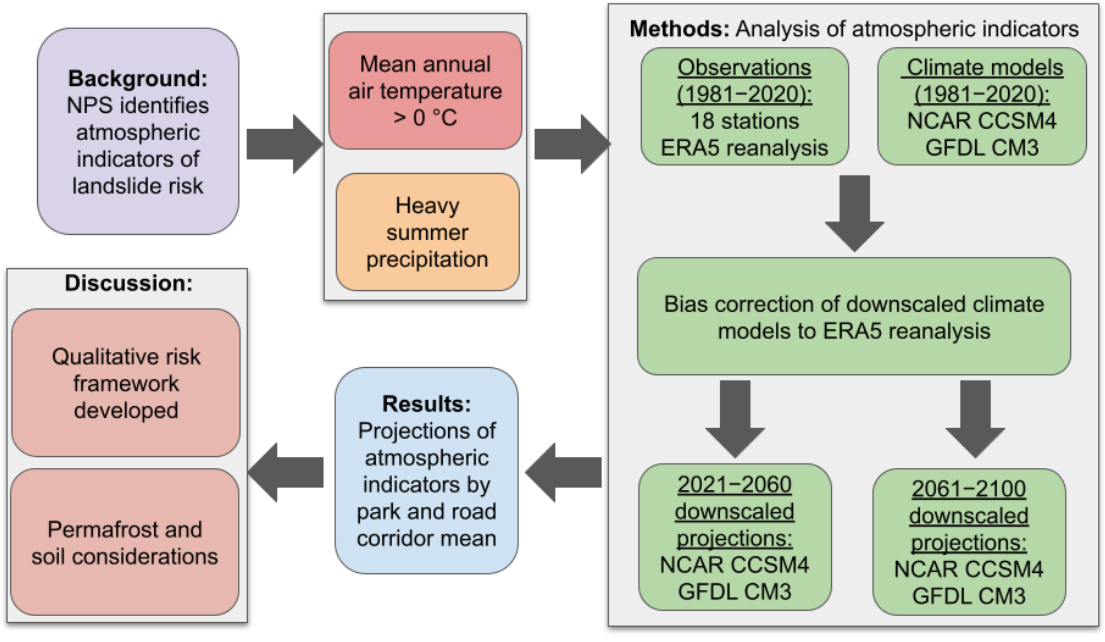
Figure 3. Flowchart of the research process involved in this study.